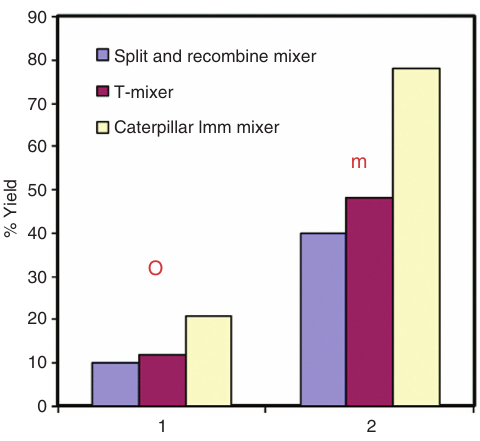
Figure 2 Effect of micromixer on the product